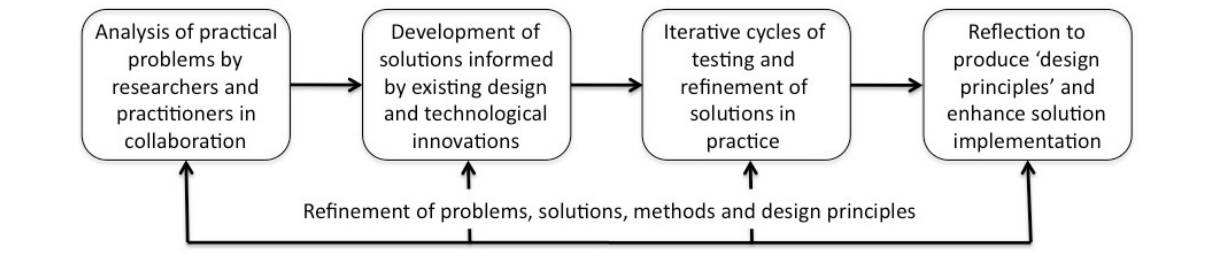
Figure 1. Design-based research process (attributed to David T Jones, sourced from Flickr and reproduced under a Creative Commons License).